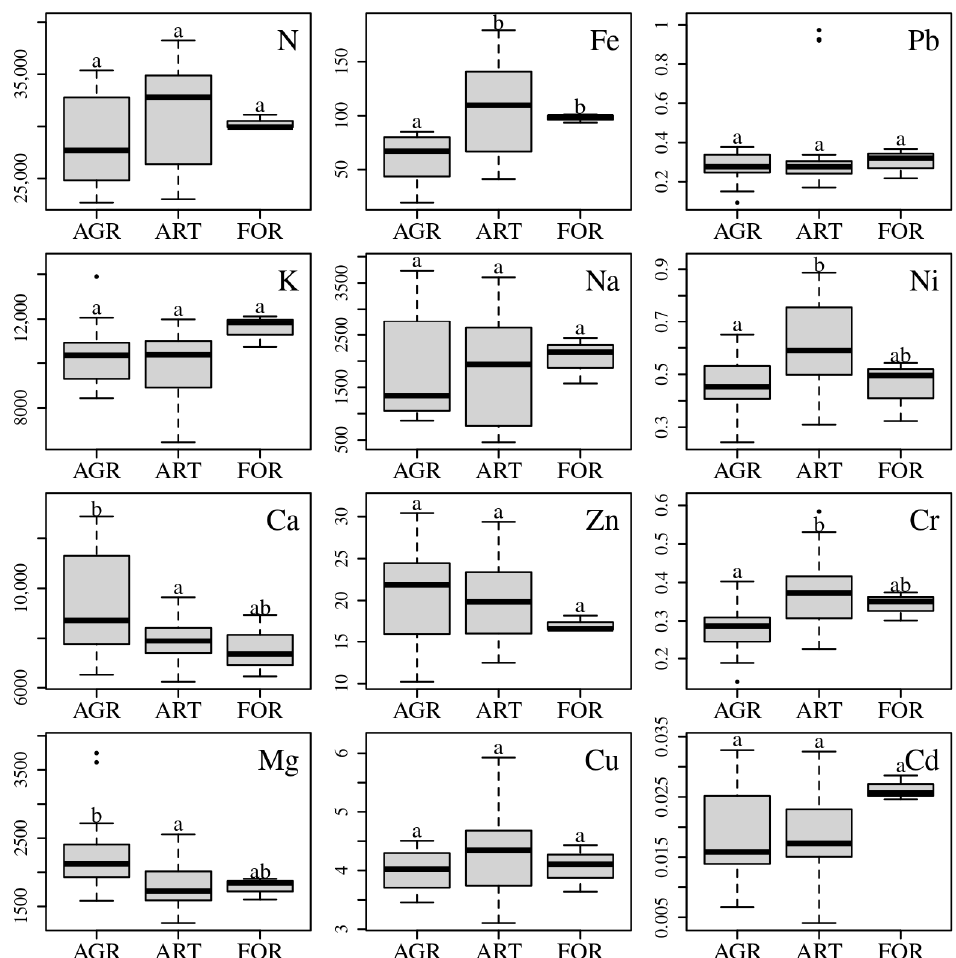
Figure 4. Median values (box–whisker plots) of leaf element concentrations (µg/g d. m. in y axes) of L. salicaria populations growing near different type of land (according to cover and use): agricultural areas (AGR), artificial areas (ART) and forest (FOR). The central line of each box indicates the median value; the boxes, the lower (25%) and upper (75%) quartiles; the whiskers are from the 10th to the 90th percentiles (typical range); the points are outliers. Population groups marked with distinct letters differ significantly ( p < 0.05).